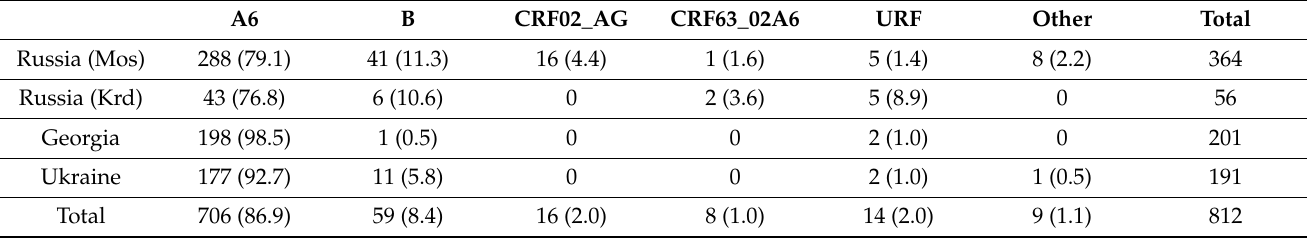
Table 2. Distribution of HIV-1 subtypes, sub-subtypes, and recombinant forms in the different coun- tries and regions studied.